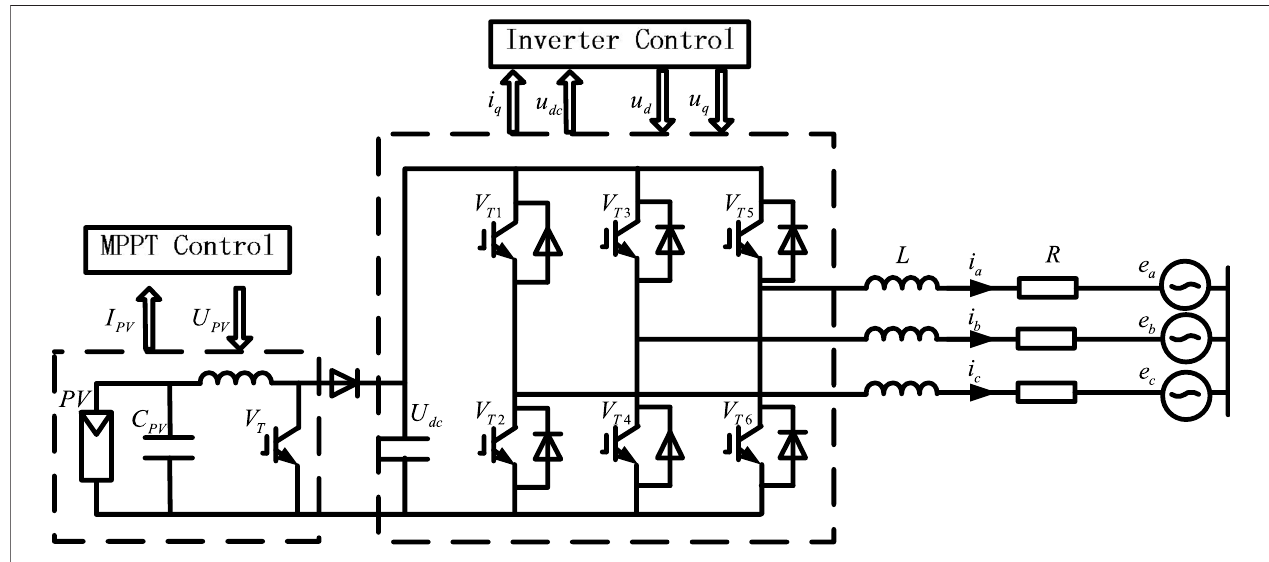
FIGURE 1 | Three-phase photovoltaic grid-connected system structure